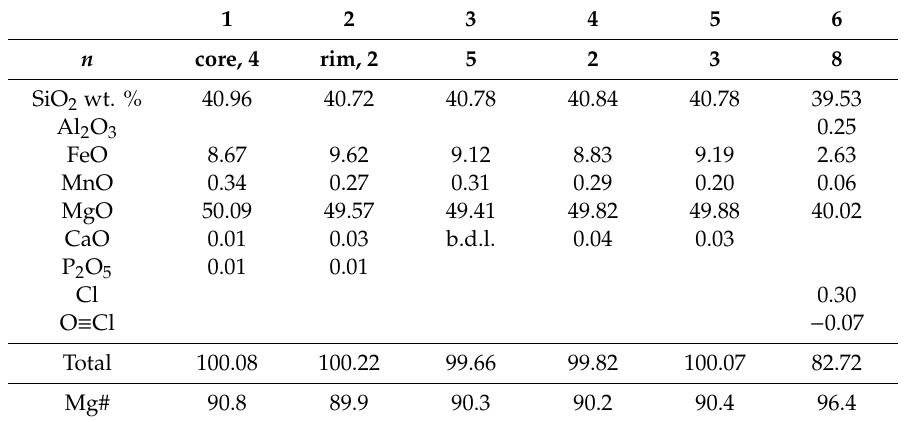
Table 1. Composition of forsterite and lizardite, Parker phlogopite mine, Notre-Dame-du-Laus, Qu é bec. 1